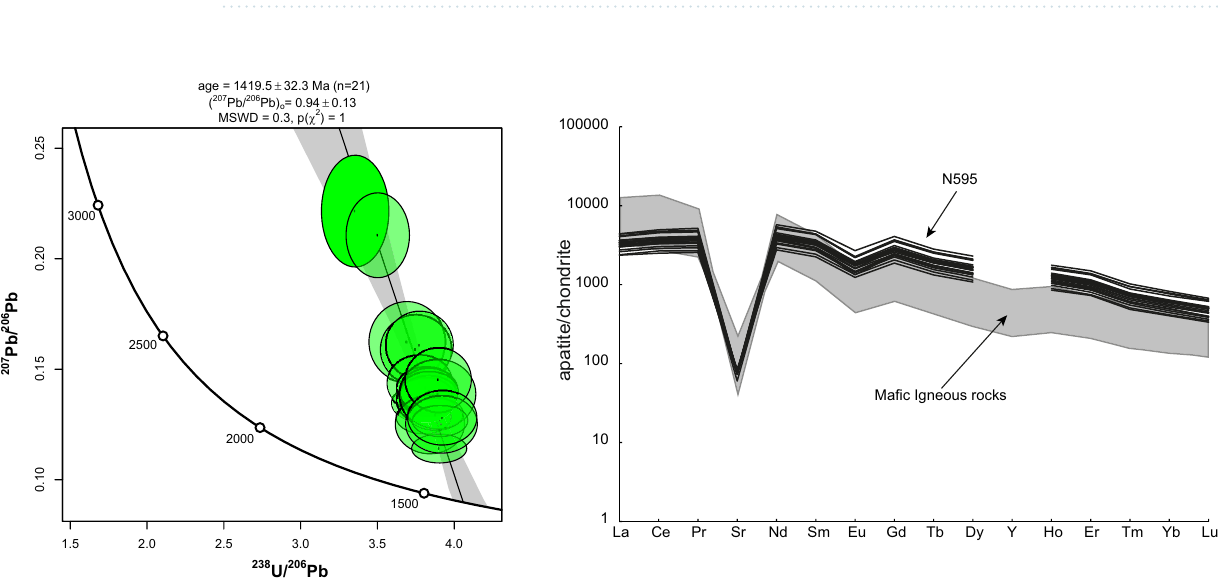
Figure 5. Tera-Wasserburg concordia diagram for the dated apatite grains (on left). Weighted mean age is presented with 1 s error. In discussion we used 2 s error. Chondrite normalized rare earth elements spectra for analyzed apatite grains (on right). Grey field denotes to a typical range of apatite REE compositions from mafic host rocks 29 . Raw data presented in supplementary